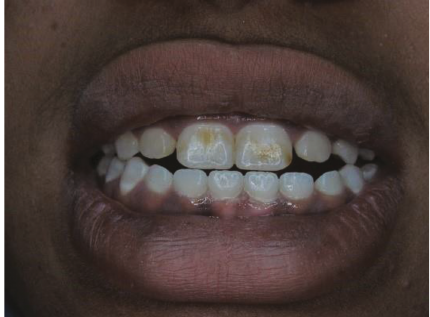
Figure 22: Case 4: unusual small teeth due to incomplete eruption (labial view).